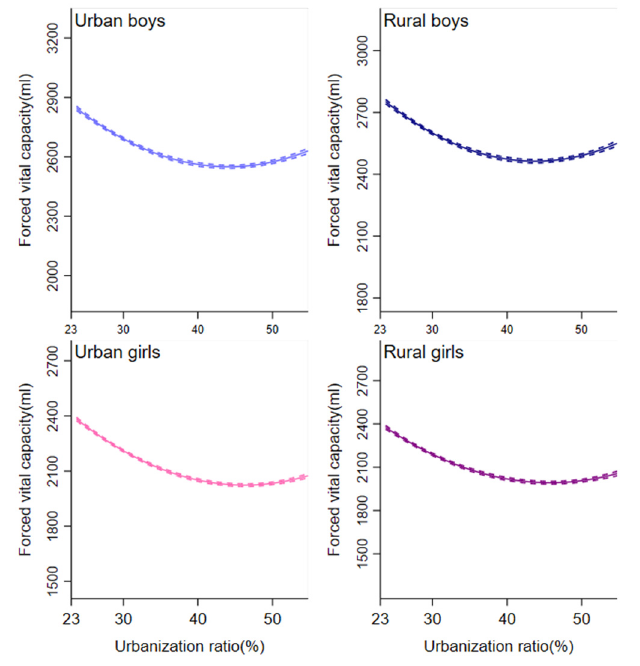
Figure 3. Association between urbanization ratio and lung function from 1985 to 2014. Separate models were fitted for lung function by adjusting for age, height, weight, time trends and other time-invariant characteristics. Dotted lines indicate 95% CIs.